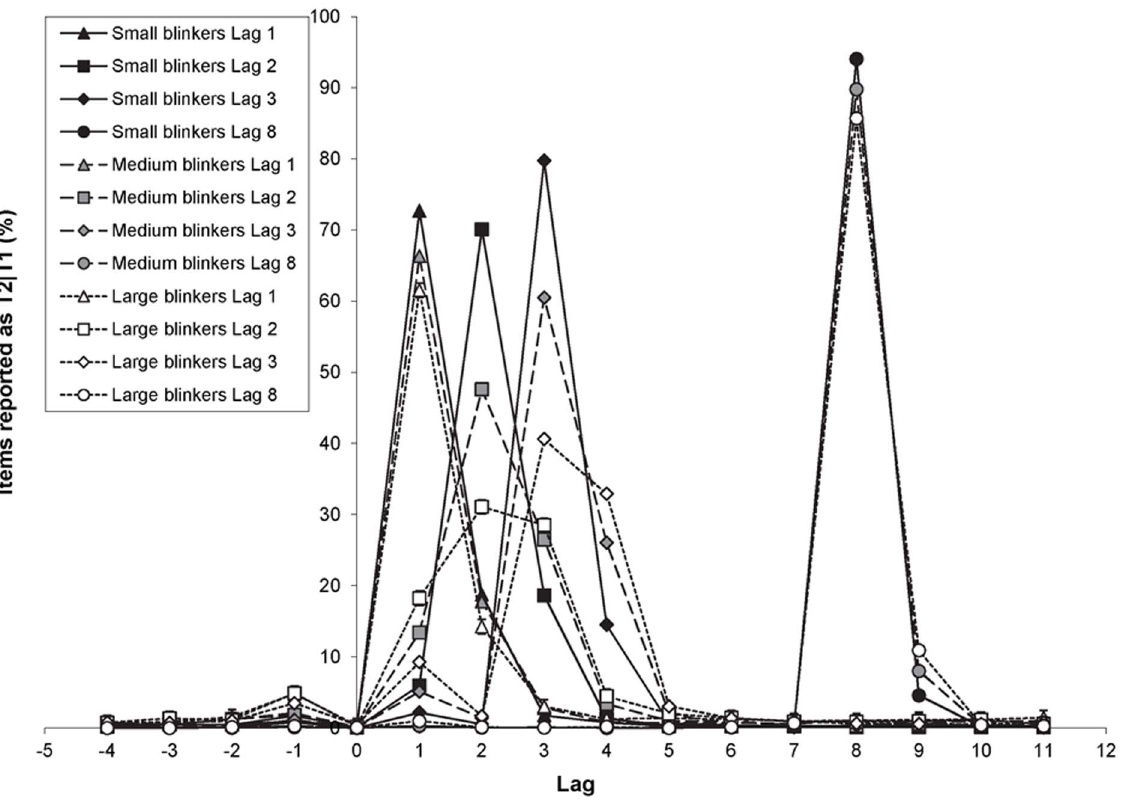
Figure 10. Distribution of T2|T1 reports in Experiment 2. The percentage of letters at a particular position in the RSVP stream that were reported as T2 given correct report of T1 as a function of lag, for small, medium, and large blinkers.